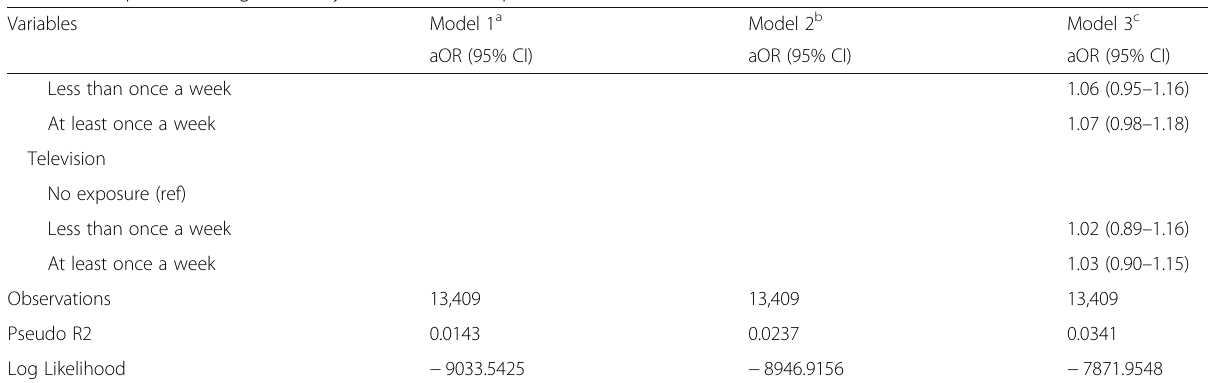
Table 2 Multivariate associations between sociodemographic characteristics, socioeconomic status, media exposure and IPV among women of reproductive age (15 – 49 years), Zimbabwe, pooled data from 2005 to 2015